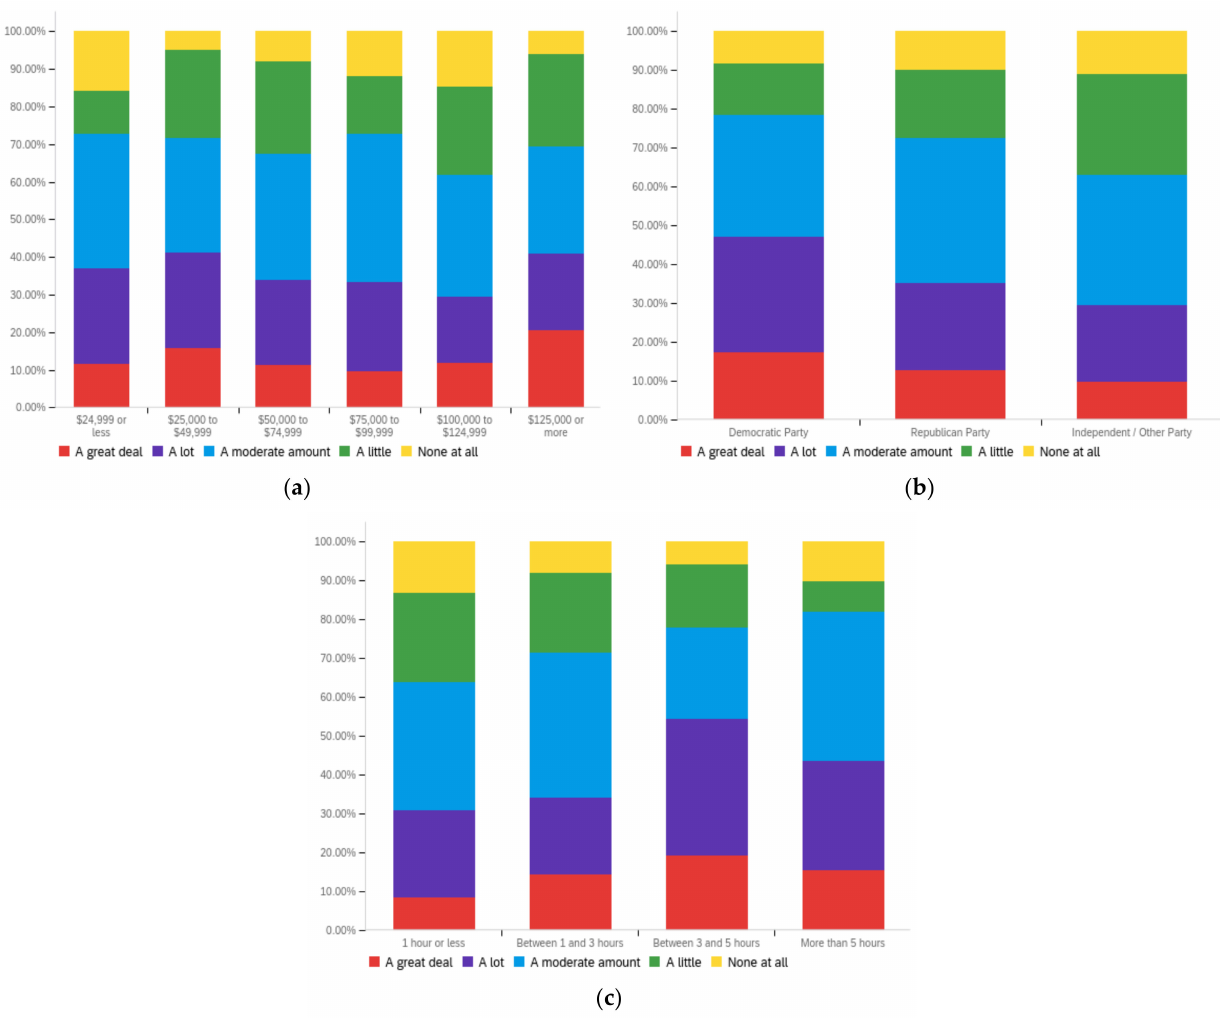
Figure A7. Article publication date—personal perception impact by: ( a ) income level (top left), ( b ) political affiliation (top right) and ( c ) online usage (bottom).